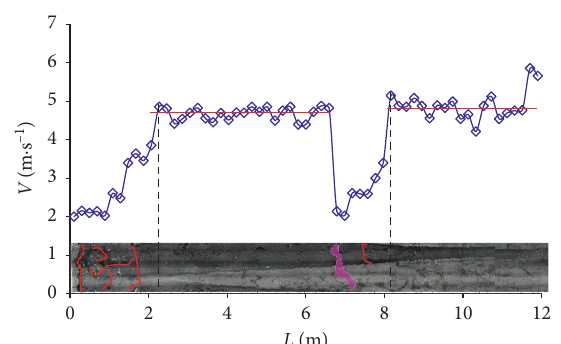
Figure 14: Acoustic test in zonal fractured rock